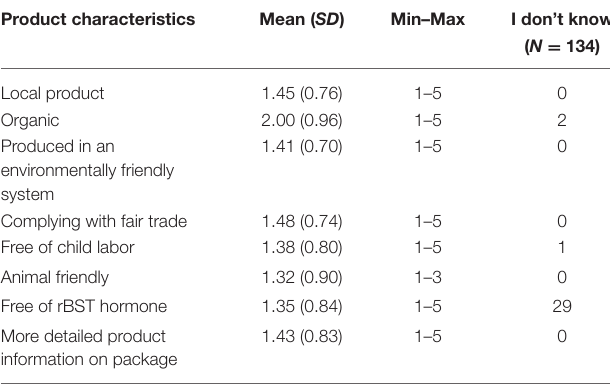
TABLE 3 | Consumer perceptions of characteristics of a differentiated